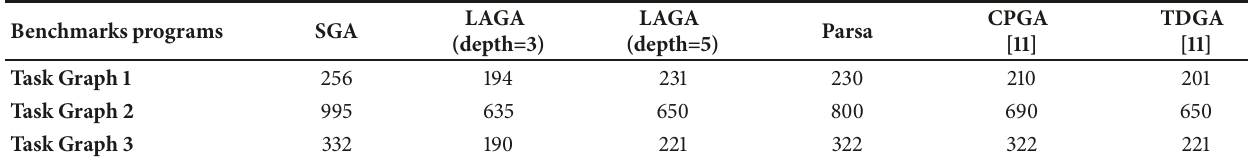
Table 8: Comparison of the genetic-based algorithms.